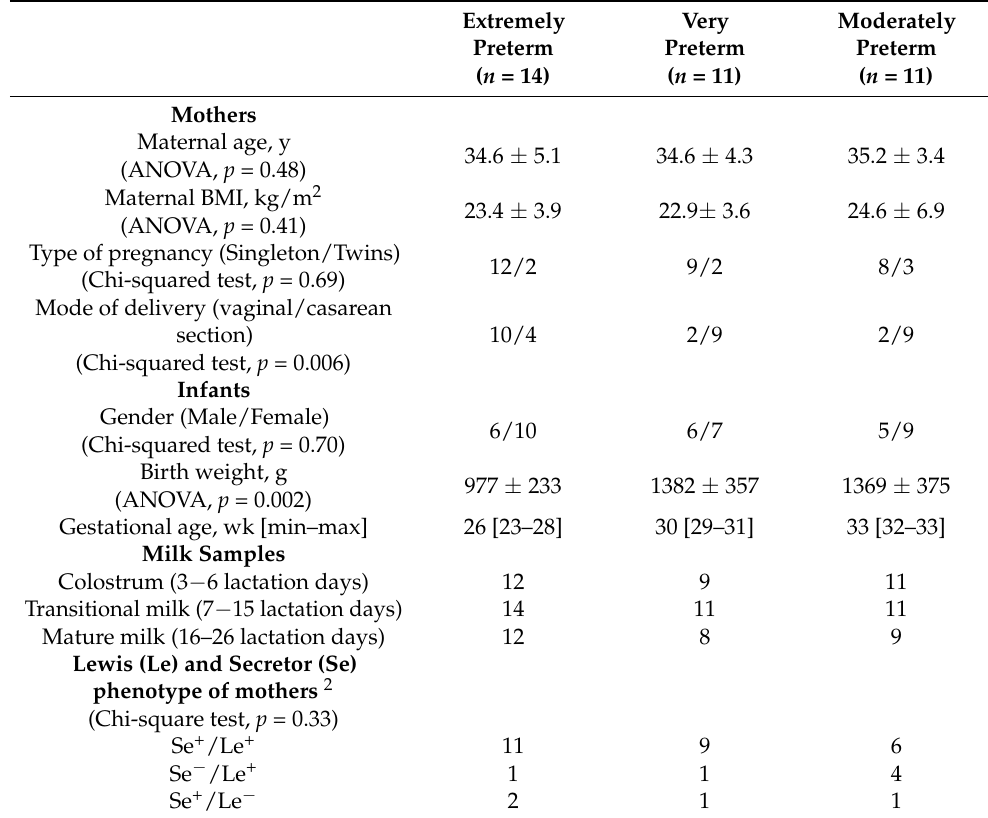
Table 1. Descriptive characteristics of mothers and infants, grouped according to the gestational maturity 1 . Extremely